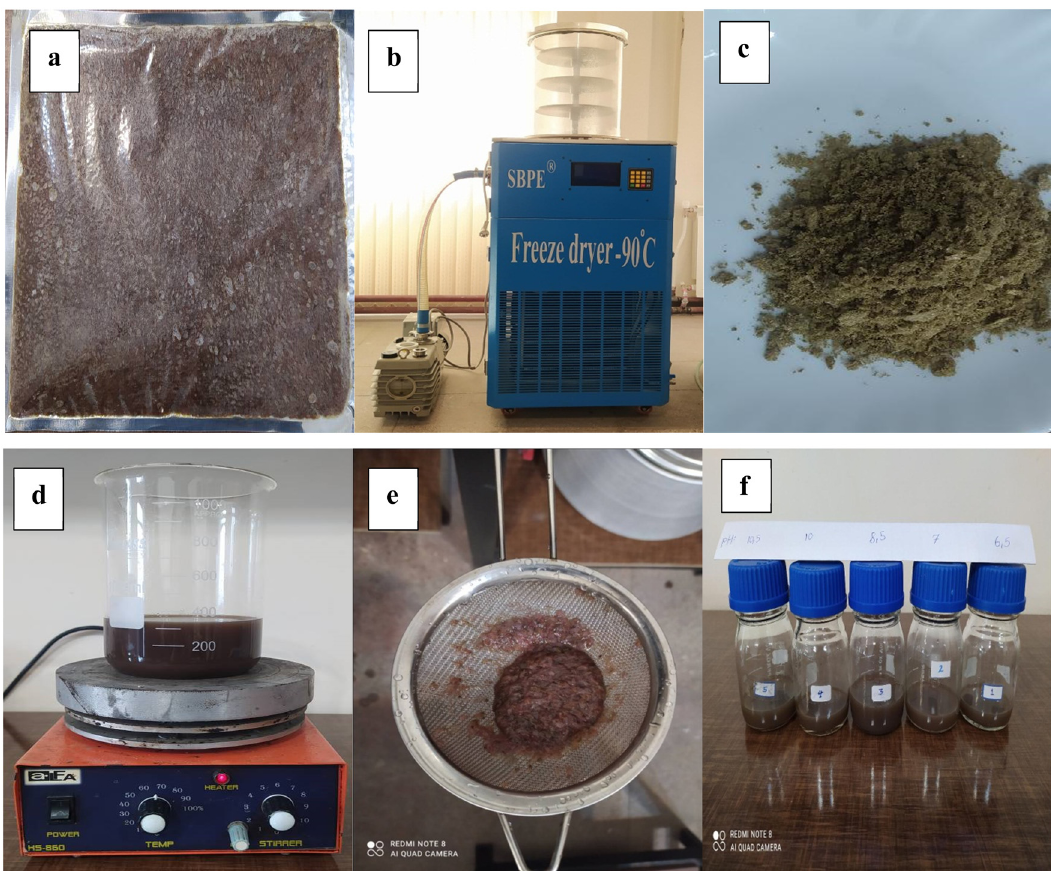
Figure 1: Schematic of the preparation of A. urumiana extract: freezed A. urumiana ( a ) , freeze dryer ( b ) , A. urumiana powder ( c ) , dissolution of powder ( d ) , fi ltration ( e ) , and pH adjustment ( f )